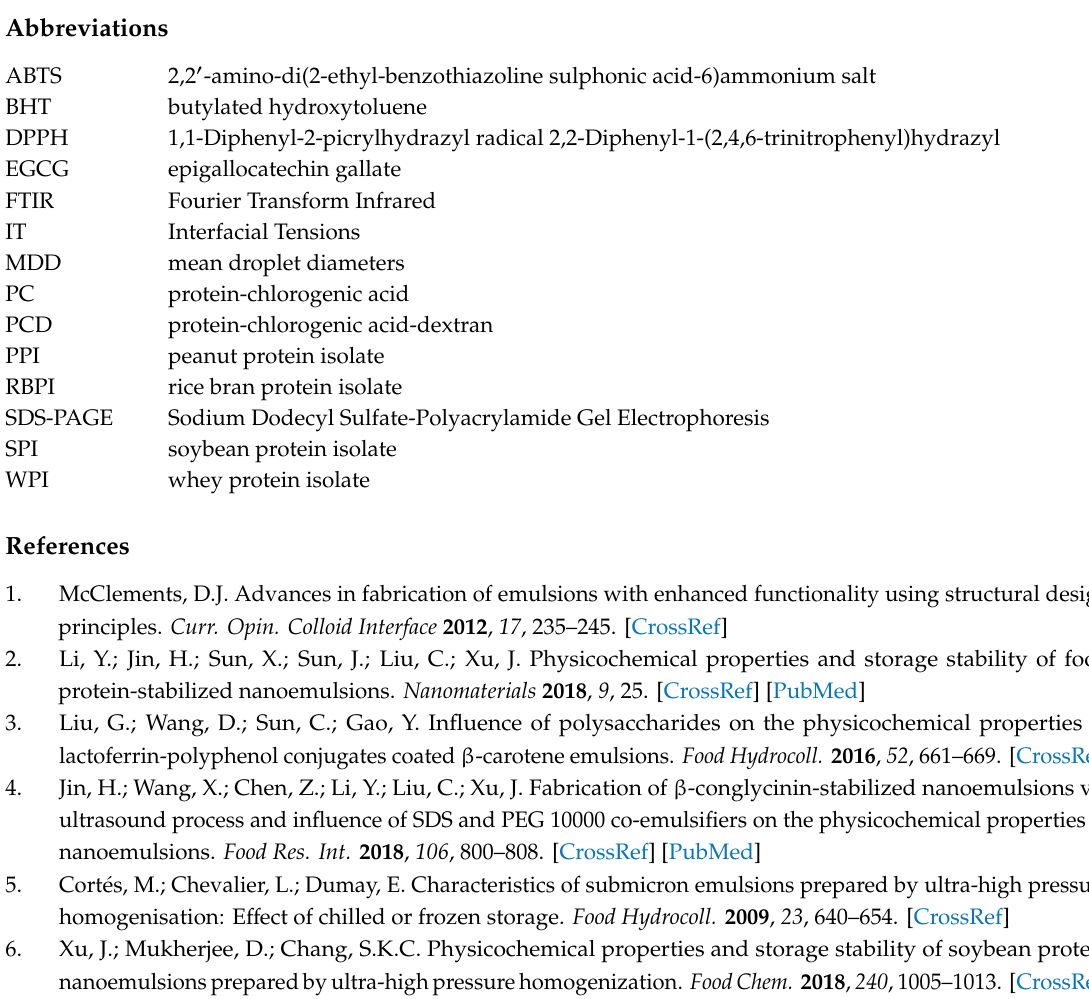
Figure S1: FTIR images of NP, PC and PCD. Figure S2: Size distribution by volume of nanoemulsions stabilized by NP, PC and PCD. Table S1: The polydispersity index (PDI) of nanoemulsions stabilized by NP, PC and